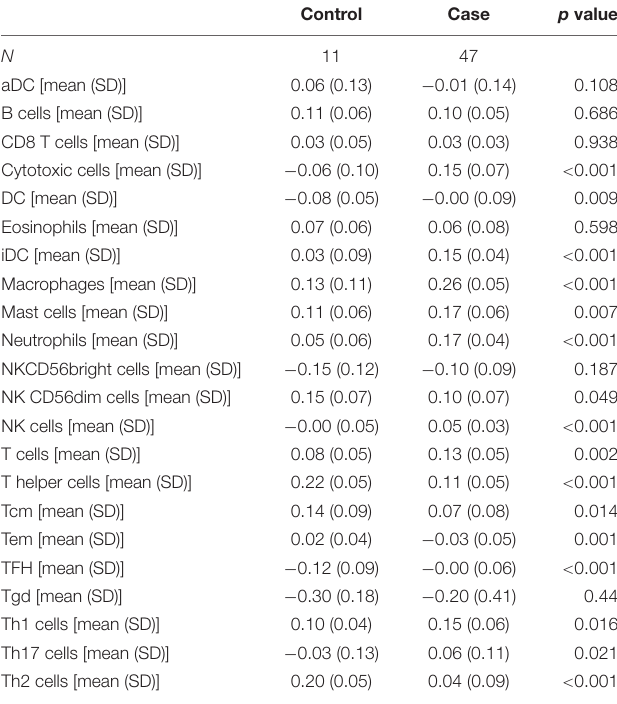
TABLE 2 | Analysis of differential expression of immune infiltration between NOA and OA.